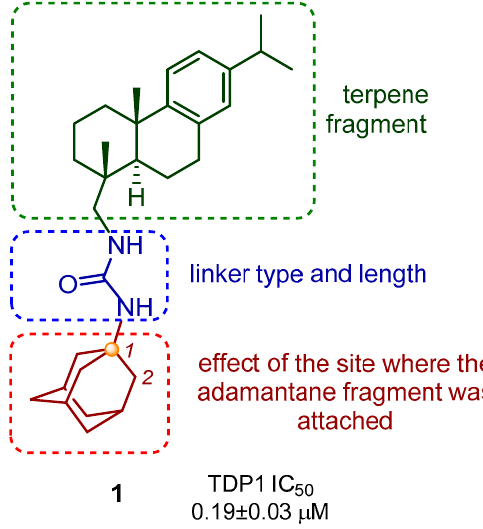
Figure 3. Design strategy for new abietylamine-based compounds.